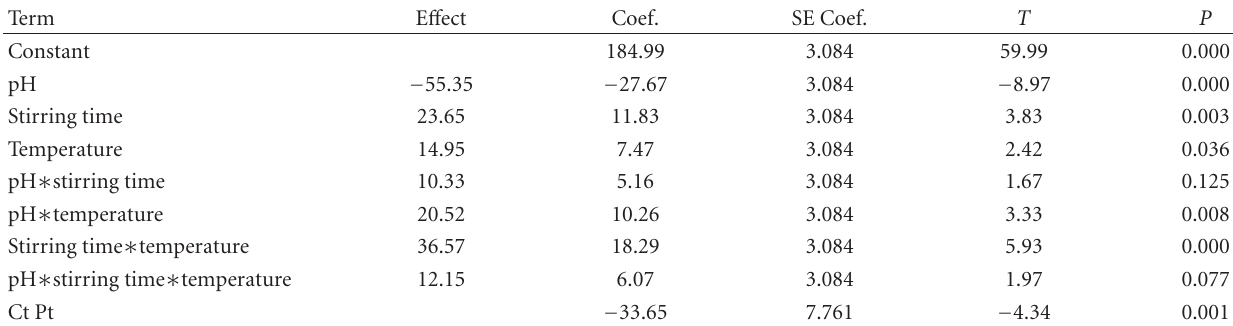
Table 5: Estimated e ff ects and coe ffi cients for concentration of leached copper.